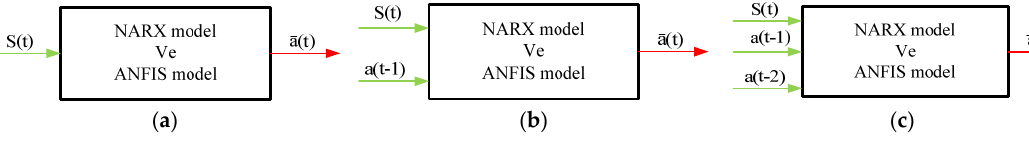
Figure 2. ( a ) Single-input single-output (SISO) and ( b , c ) multi-input single-output (MISO) models designed for the modeling of the structure behavior under seismic load.